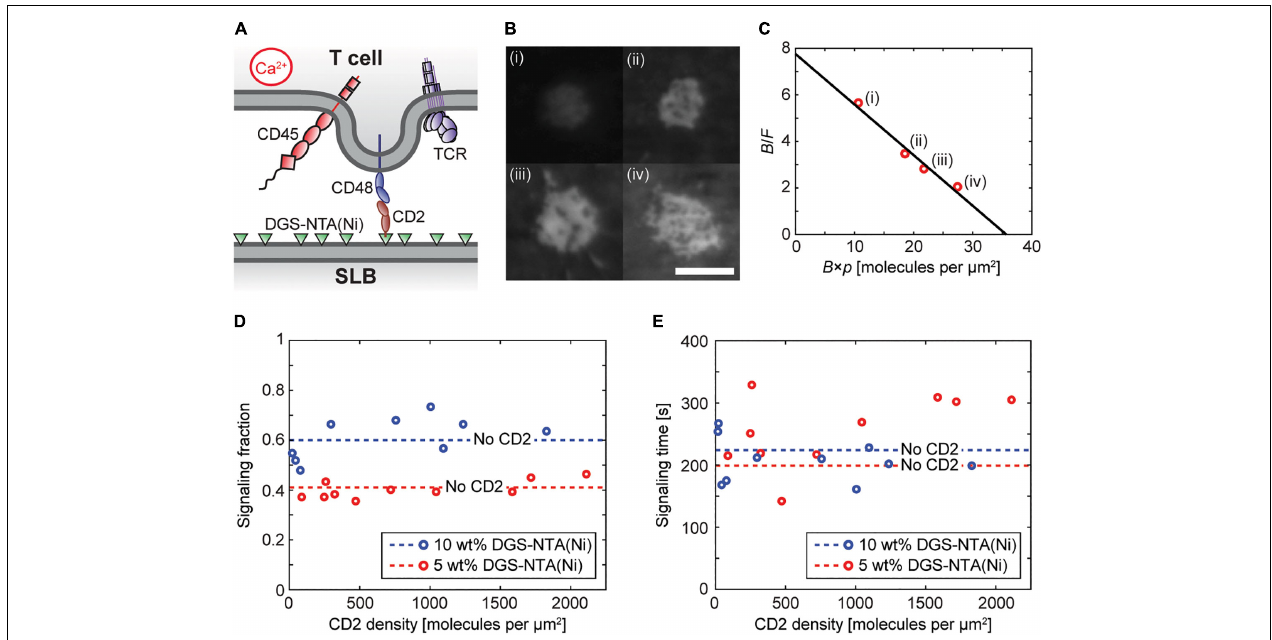
FIGURE 2 | DGS-NTA(Ni) dominates over ligand binding in inducing calcium signaling. (A) An illustration of a Jurkat T cell interacting with a rat CD2-functionalized SLB to induce calcium signaling. (B) Fluorescence images of accumulated CD2 in four different cell-SLB contacts with varying free (bound) CD2 density: (i) 68 (381) CD2 molecules per µ m 2 , (ii) 189 (659) CD2 molecules per µ m 2 , (iii) 249 (697) CD2 molecules per µ m 2 , and (iv) 361 (739) CD2 molecules per µ m 2 . The average cell-SLB contact area increased from 19 to 26 µ m 2 between (i) and (iv). The scale bar is 5 µ m and the scale is the same for all images. (C) Zhu-Golan plot for the data in (B) (red circles) with: F , free CD2 density; B , bound CD2 density; and p , the fraction of the cell surface area within the cell-SLB contact. The solid line is a linear fit to the data. (D,E) The signaling fraction and average signaling time at different densities of CD2 on SLBs containing 5 wt% DGS-NTA(Ni) (red circles) and 10 wt% DGS-NTA(Ni) (blue circles). Each data point represents one experiment with 150 analyzed cells. The dashed lines represent the average values on a ligand-free SLB [5 wt% DGS-NTA(Ni): blue dashed line, 10 wt% DGS-NTA(Ni): red dashed